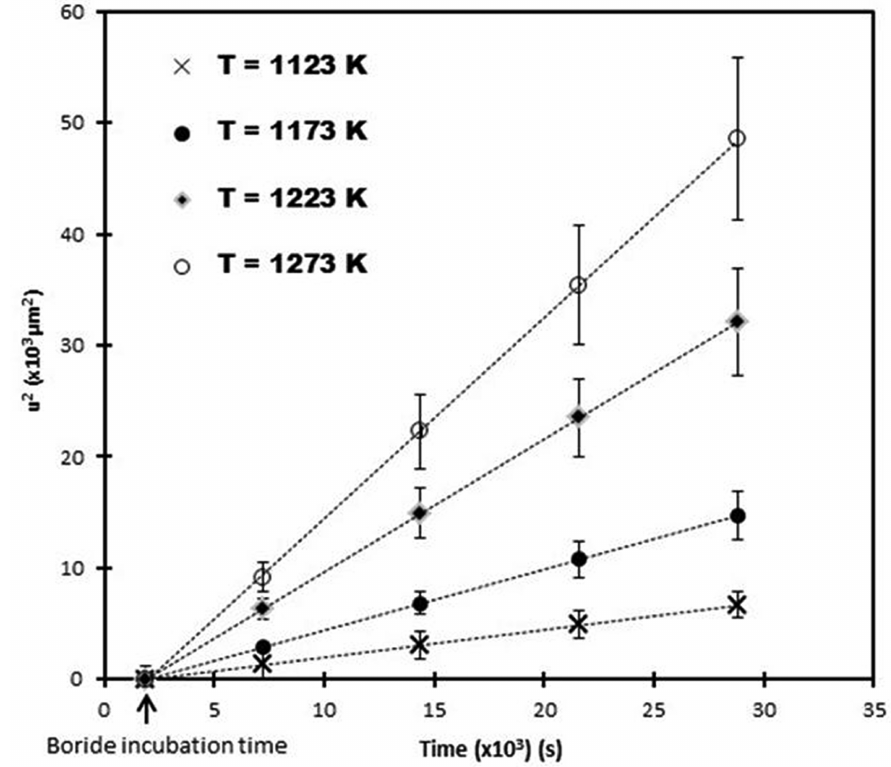
Figure 5: Square of Fe 2 B layer thickness as a function of boriding time at increasing